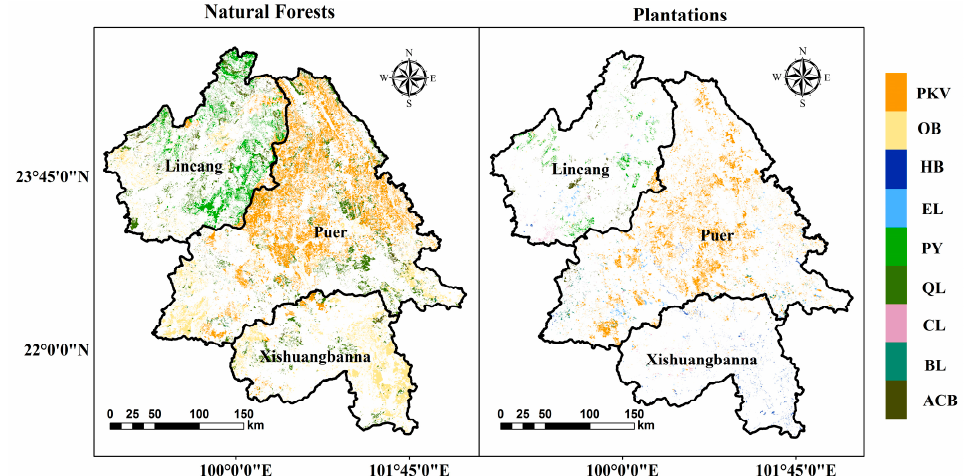
Figure 8. Spatial distribution of nine tree species in natural and plantation forests.